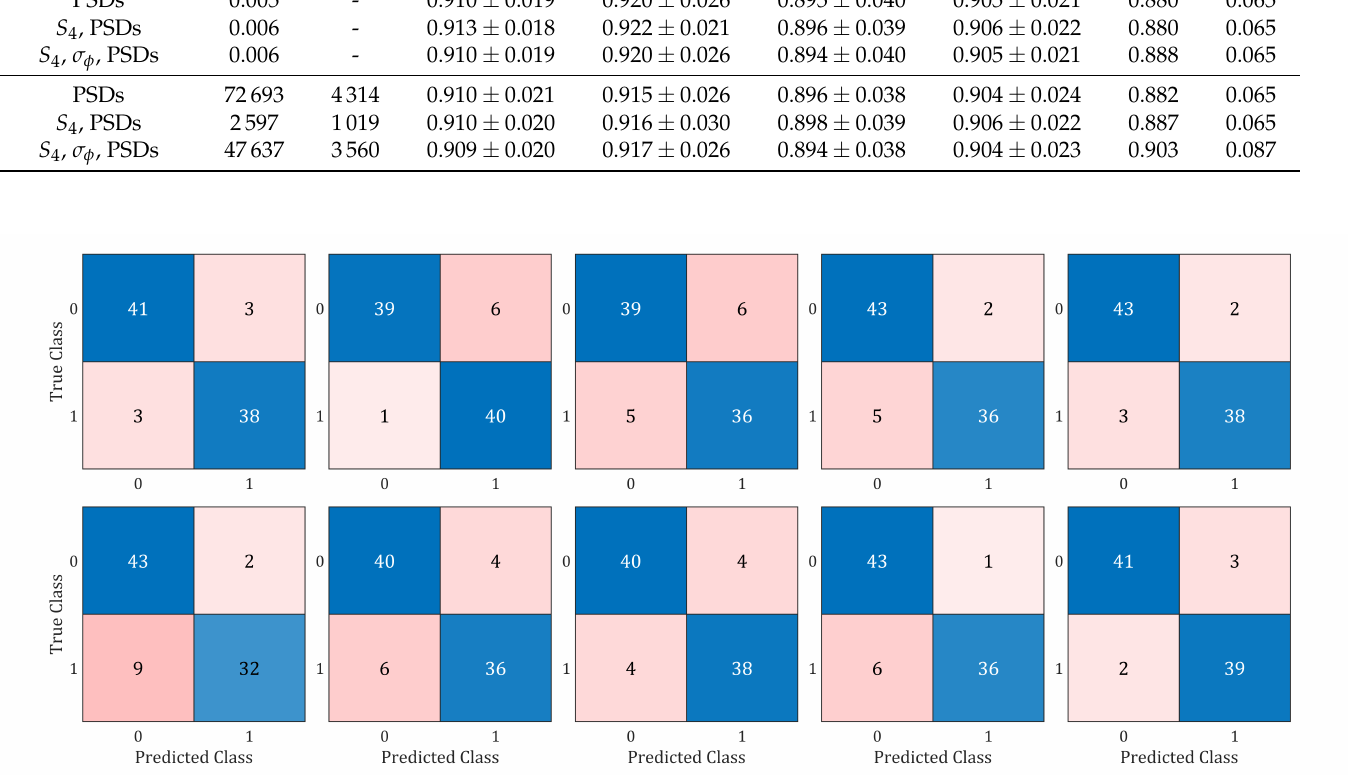
Figure 18. Confusion matrices for test folds: intensity and phase PSDs as training features and linear